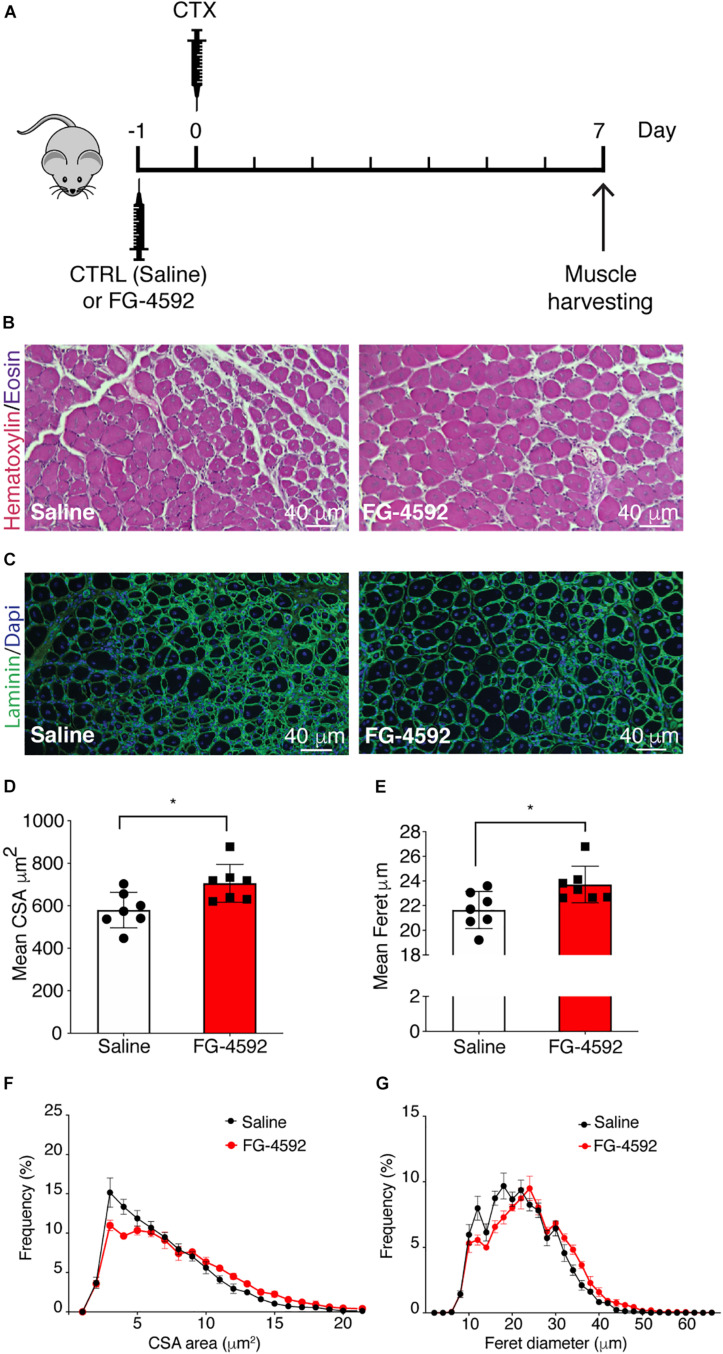
Effects of FG-4592 treatment on muscle regeneration. (A) Schematic illustration of the experimental procedure: 24 h before cardiotoxin (CTX) injury of tibialis anterior (TA) muscle, mice were injected by i.p. with FG-4592 (10 mg/kg). Mice were sacrificed 7 days after CTX-induced injury, and TA muscles were collected. (B) Immunohistochemical detection of hematoxylin/eosin in FG-4592 pre-treated mice, compared to controls. Scale bars = 40 μM (n = 7 mice for each group). (C) Immunofluorescence staining of laminin (green) in saline and FG-4,592 pre-treated mice. Nuclei were stained with Hoechst 33,342. Scale bars = 40 μM (n = 7 mice for each group). (D,E) Quantification of CSA (D) and minimal Feret diameter (E) averages in FG-4592 or saline pre-treated mice. (F,G) Representation of CSA (F) and minimal Feret diameter (G) distribution in saline or FG-4592 pre-treated mice. Data information: all data represent mean ± SD. *p < 0.05 (Student’s t-test).